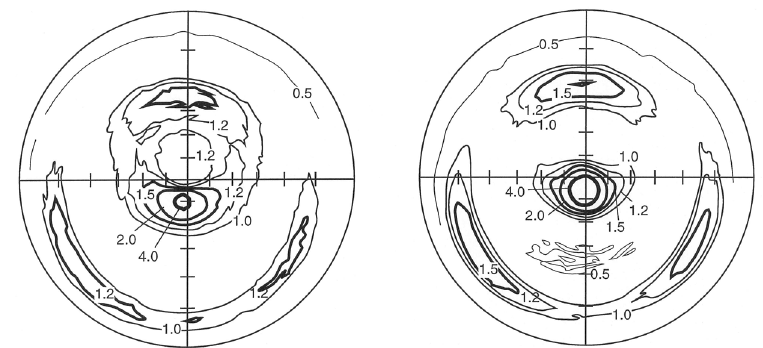
Figure 7. (111) polar plots obtained from 2 µ m-thick Al films deposited on polyimide sheet after O 2 plasma pretreatment for 40 s. Before annealing ( left ) and after annealing ( right ) at 350 °C for 30 min.